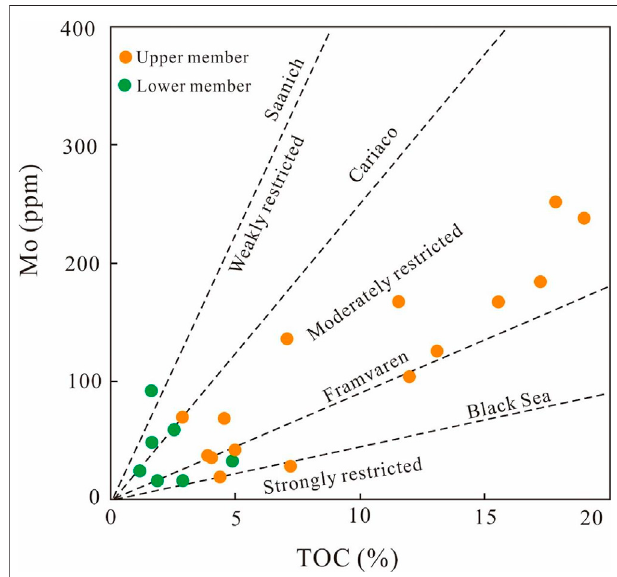
FIGURE 5 | Plot of the Mo concentration versus TOC from the shale samples in the Gufeng Formation at the Putaoling section. The dashed lines represent the regression trends for four modern marine systems (Saanich Inlet, Cariaco Basin, Framvaren Fjord, and Black sea), mirroring variable degrees of hydrographic restriction.